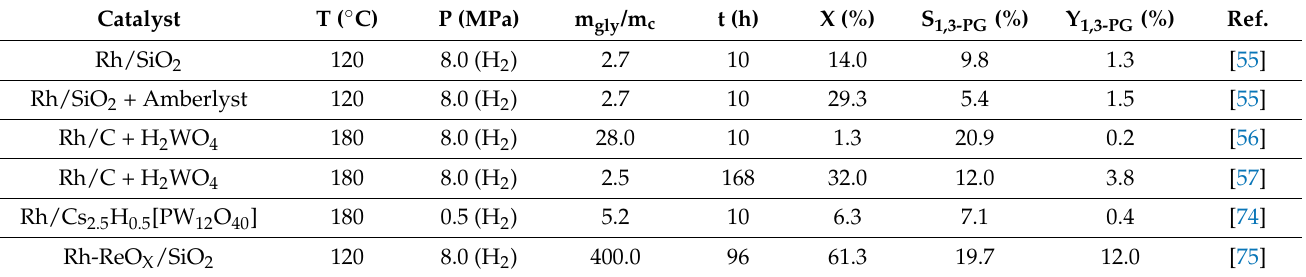
Table 2. The hydrogenolysis of glycerol to 1,3-PG using Rh catalysts operating in liquid phase batch